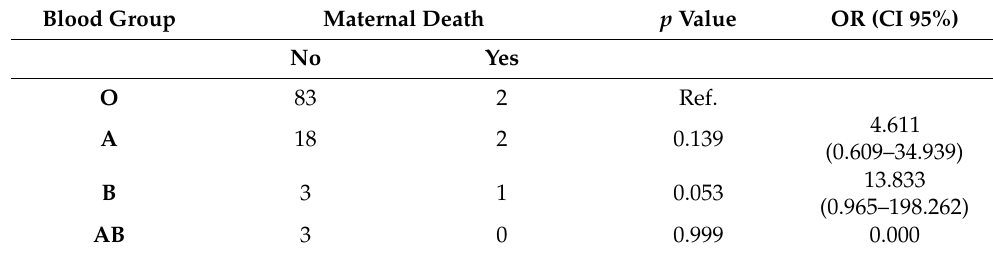
Table 4. Association of maternal death with blood groups among mothers with severe COVID-19. Blood